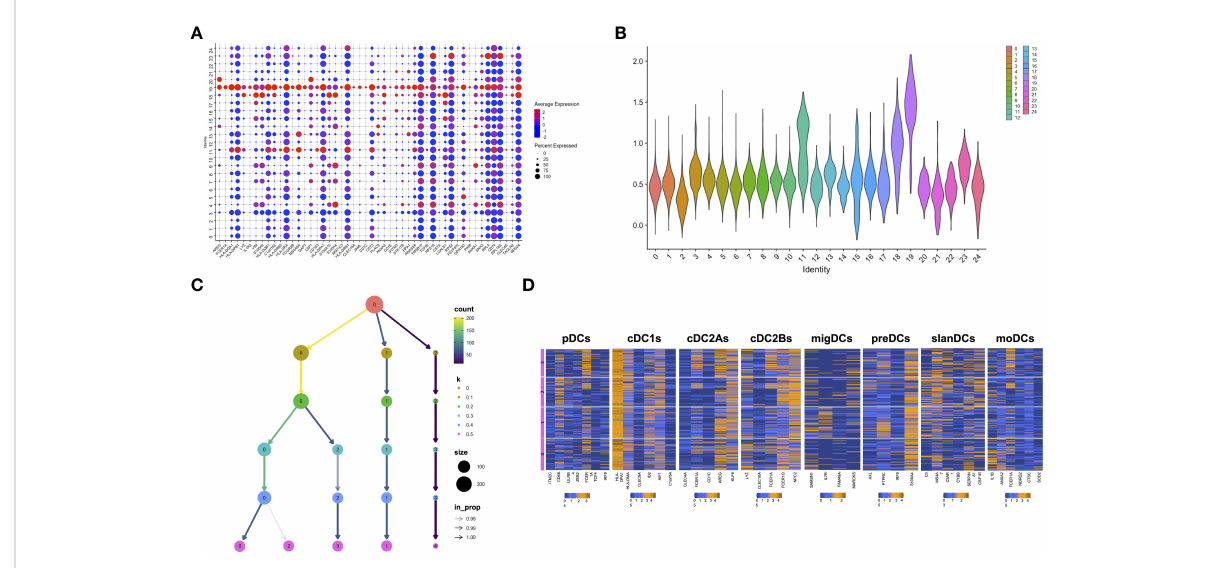
FIGURE 3 scRNAseq con fi rms the presence and heterogeneity of TIDCs. (A) Dot plot showing the fi rst 50 DEGs (p adj <0.05) between cluster 19 and all the other clusters that compose CD45 + cells obtained from 7 tumor tissues and 2 healthy brain tissues from 8 glioma patients. All 50 genes are known to be enriched or expressed by human DCs, thus indicating that cluster 19 is the cluster of DCs. Color scale indicates the average expression level of genes; dot size indicates the percentage of gene-expressing cells in each cluster. (B) By applying the AddModuleScore function that allows to compare the expression of a speci fi c set of genes among clusters, the expression of the 50-gene signature characterizing cluster 19 was visualized in a violin plot. (C) Reclustering of cluster 19 represented in a clustering tree based on kk-means. Nodes colored according to the value of k and sized according to the number of cells they represent. Edges colored according to the number of cells (from blue representing few to yellow representing many). Cluster labels are randomly assigned by the kk-means algorithm. (D) Heatmaps showing the mean expression of genes characteristic of pDCs, cDC1s, cDC2As, cDC2Bs, preDCs, migDCs, slanDCs, and moDCs, in clusters from 0 to 3 at resolution 0.5. Expression values are zero-centered and scaled for each gene. Each gene name is reported on the bottom of each